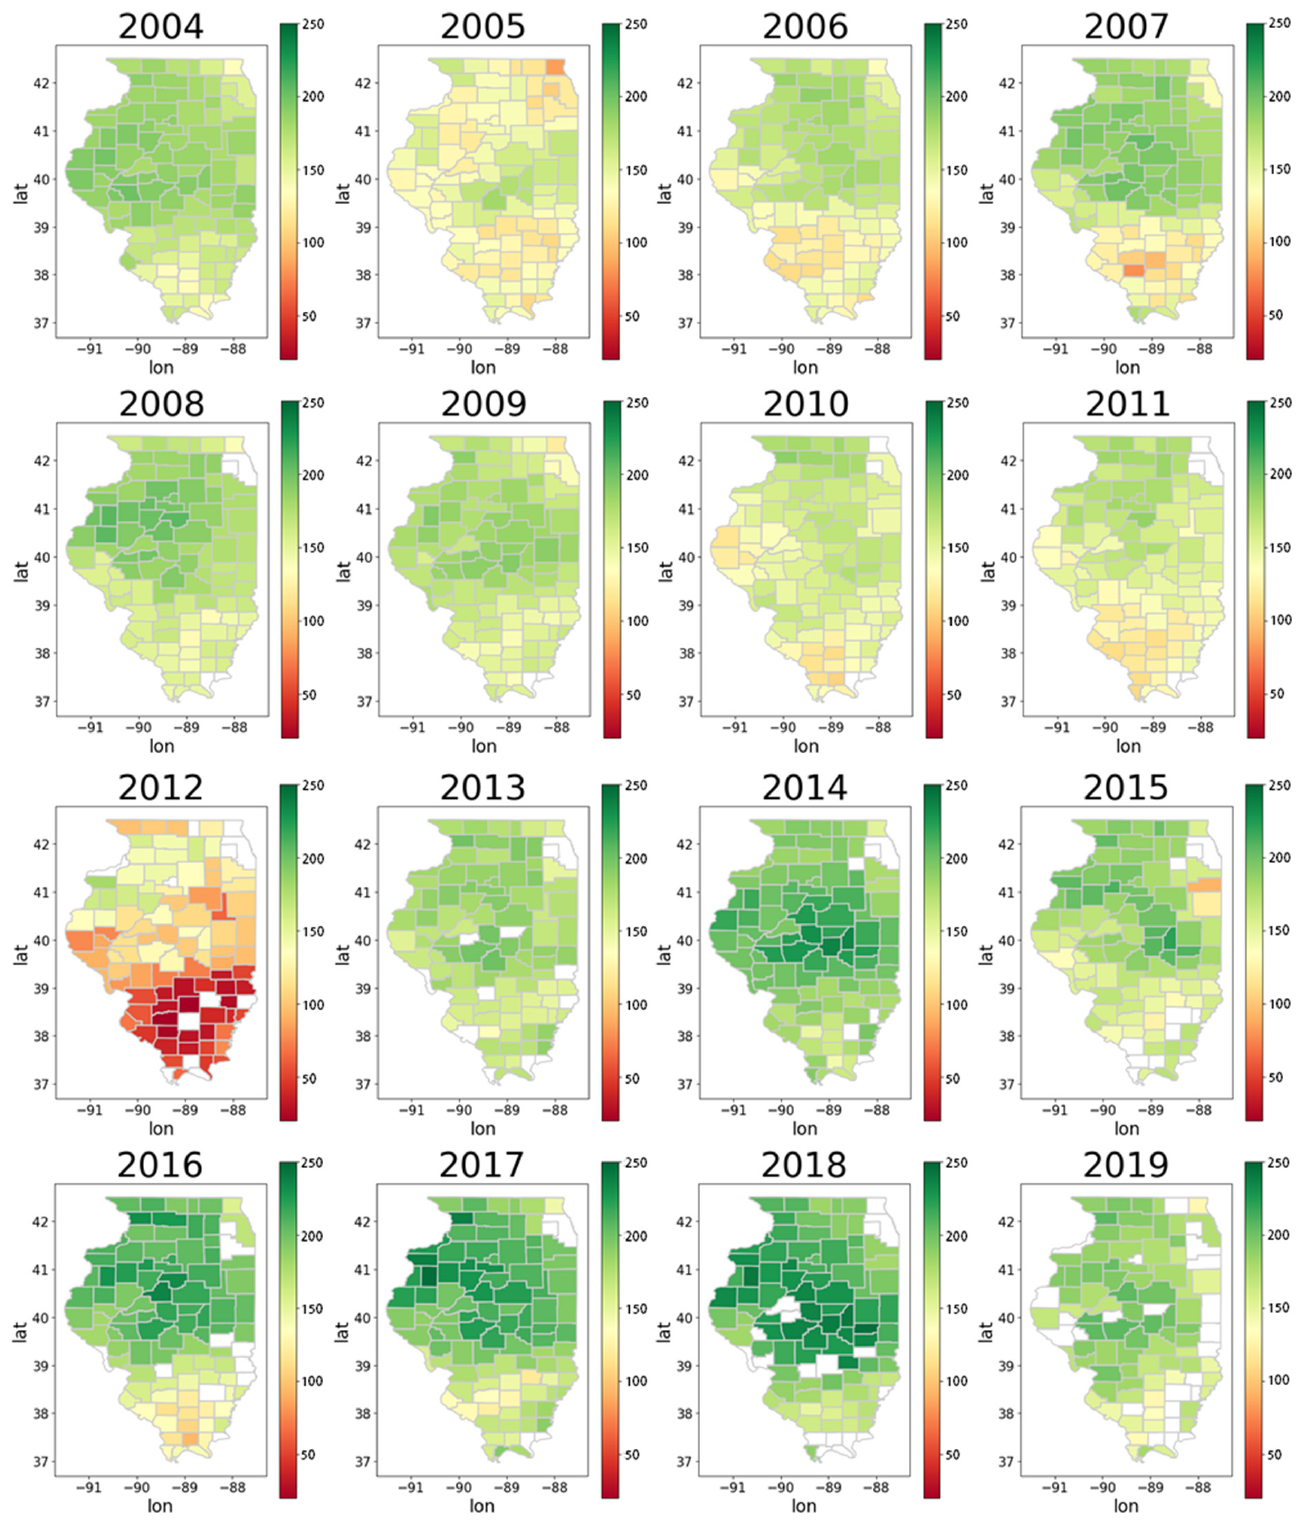
Figure 3. Distribution of corn yields (bushels per acre) in Illinois, 2004–2019.